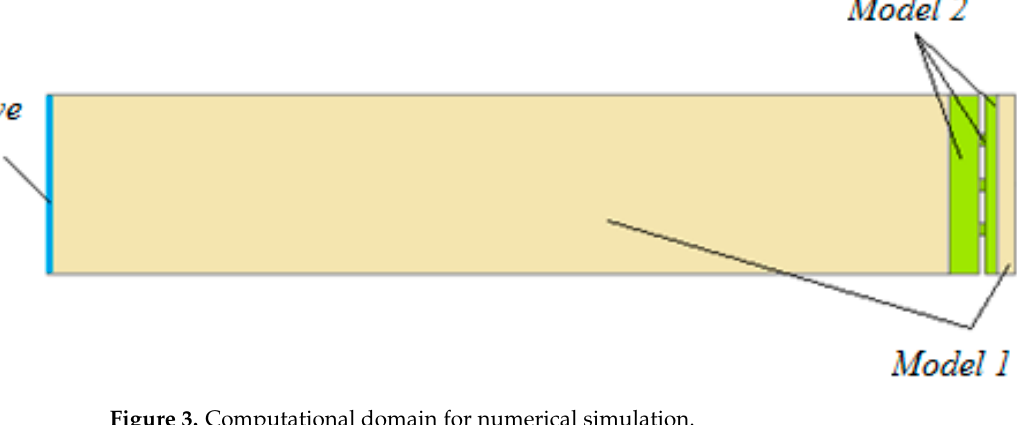
Figure 3. Computational domain for numerical simulation. The geometric characteristics of the cylindrical resonator are presented in Table 1. Table 1. Geometry of the resonator under consideration.